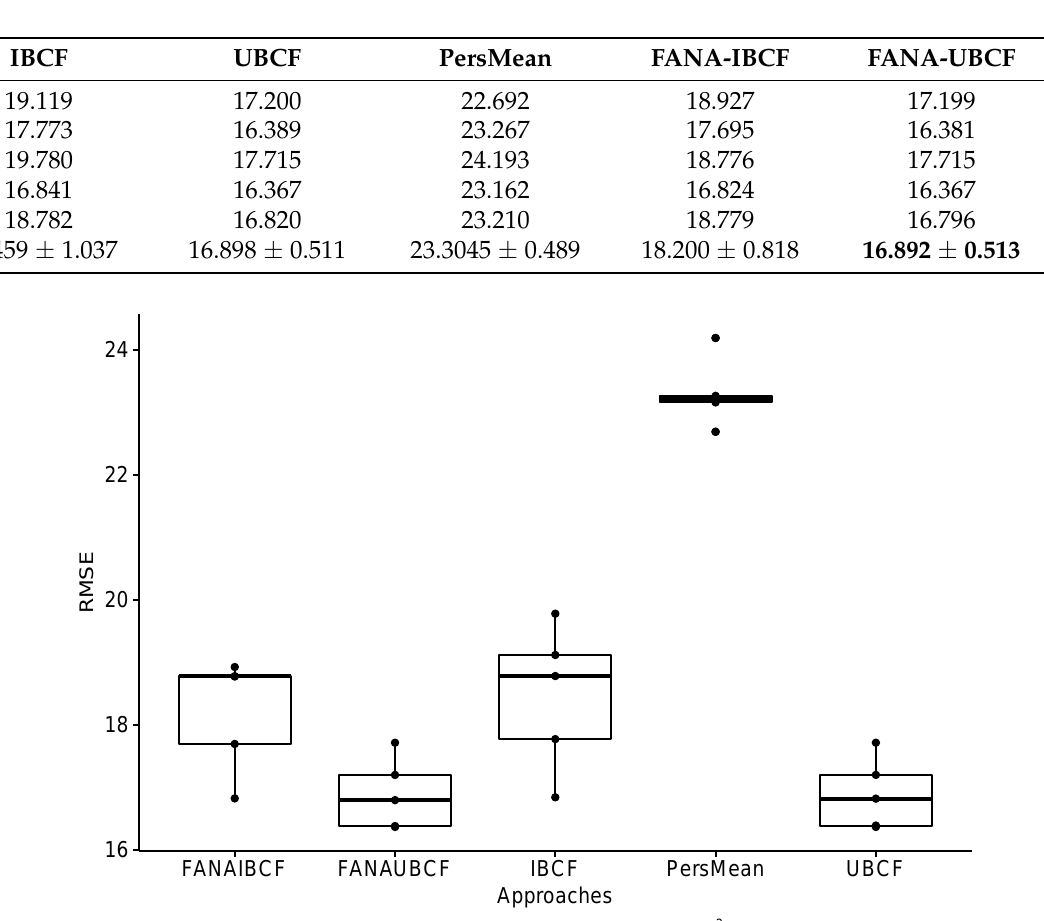
Table 5. Comparison of root mean squared error (RMSE) performance among IBCF, UBCF, PersMean, and our proposed approach, FANA-CF, using 5-fold cross validation. We have calculated the average RMSE and the standard deviation for each approach.